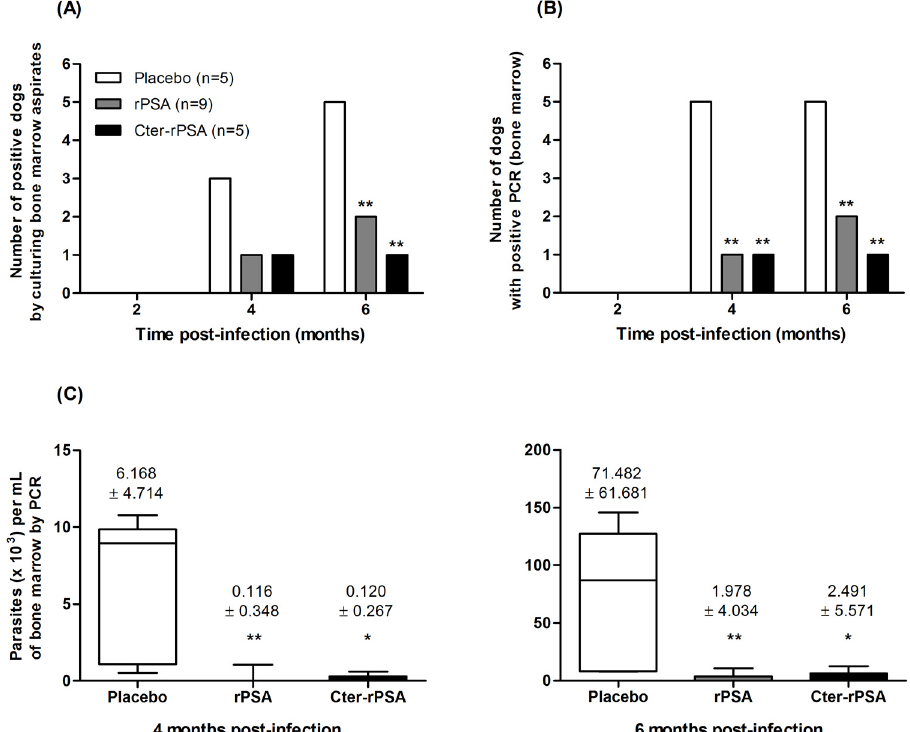
Fig 1. Parasitological evaluation of placebo and vaccinated dogs. The presence of (A) live Leishmania parasites was highlighted by subculture analysis of bone marrow aspirates isolated from dogs of placebo (n = 5), rPSA/QA-21 (n = 9) and Cter-rPSA (n = 5) groups at 2, 4 and 6 months post-challenge (PC). A sample was considered as positive when Leishmania parasites were detected during the seeding or subculture analysis. The presence of (B) Leishmania DNA and (C) the parasite load in bone marrow aspirates of dogs of each group were assessed by quantitative PCR. Dogs were considered as positive when the titer was superior to 40 parasites per mL. Data are expressed as (B) the number of dogs with positive PCR at each time points post-challenge and (C) the mean number of parasites per mL of bone marrow aspirates at different times post-challenge (4 and 6 months) ( * p < 0.05, ** p < 0.01, *** p <